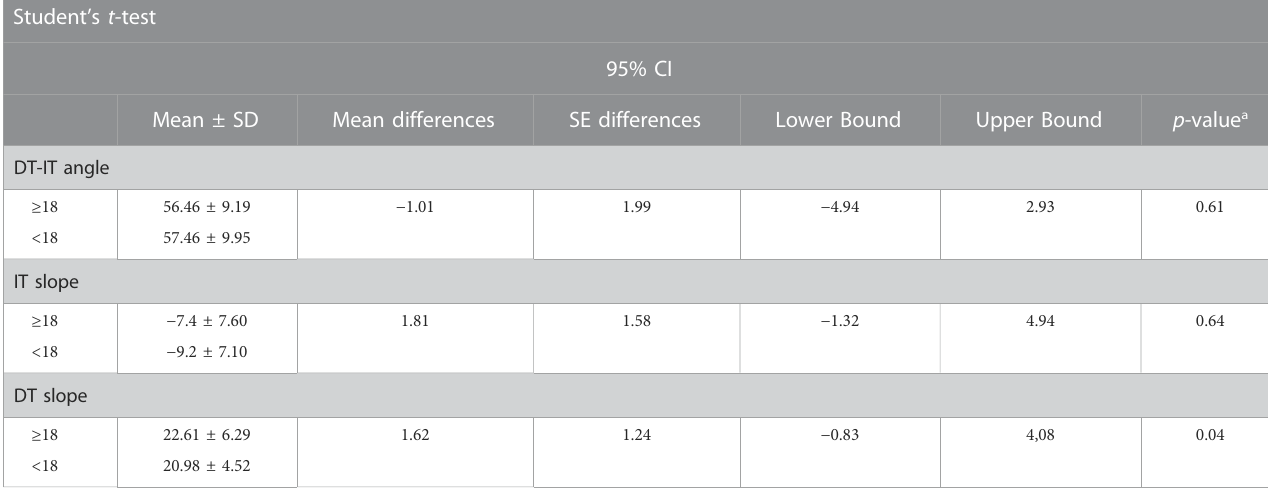
TABLE 6 Student ’ s t -test analysis of the DT-IT angle, IT slope, and DT slope measured by observer 1 depending on the age ranges ( ≥ 18 y and < 18 y). Student ’ s t-